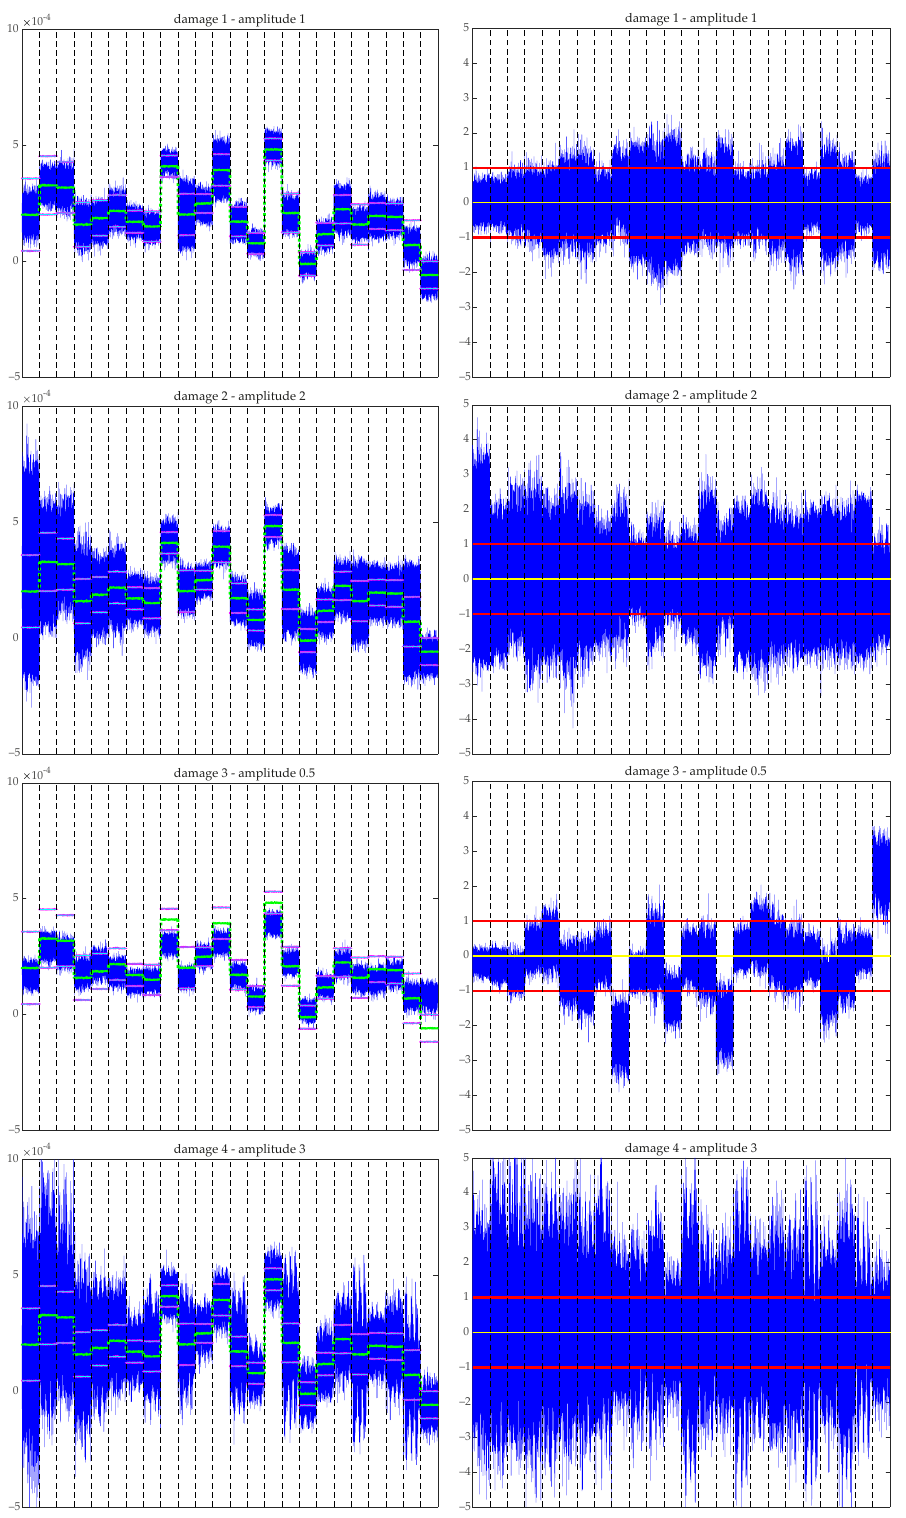
Figure 9. Raw signal (left) versus MCUGS signal (right) for four damaged samples. Raw signals (blue) are shown along with the mean values µ k (green) and the representation of the standard deviations µ k j (magenta). The normalized data have zero mean (yellow) and unitary deviation (red). Dashed vertical lines separate the measures of the 24